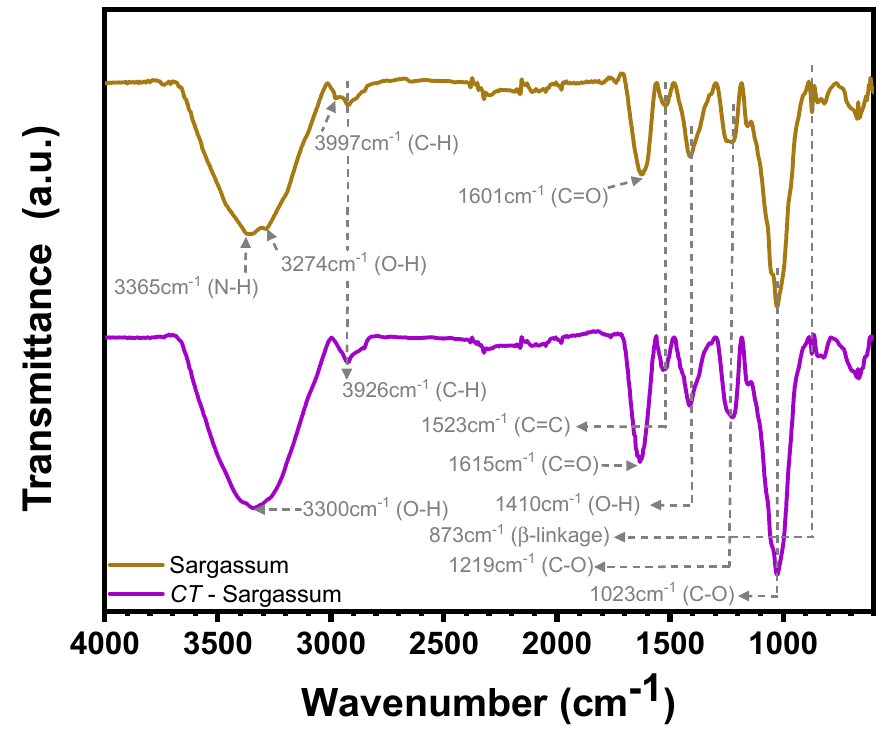
Figure 3. Fourier Transform Infrared (FTIR) analysis of dry Sargassum spp. and CT- Sargassum spp.